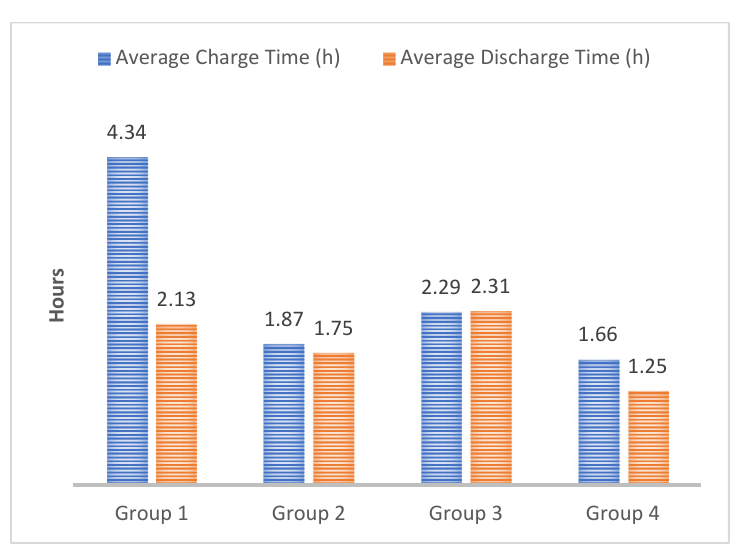
Figure 4. Average charge and discharge time for each battery group.